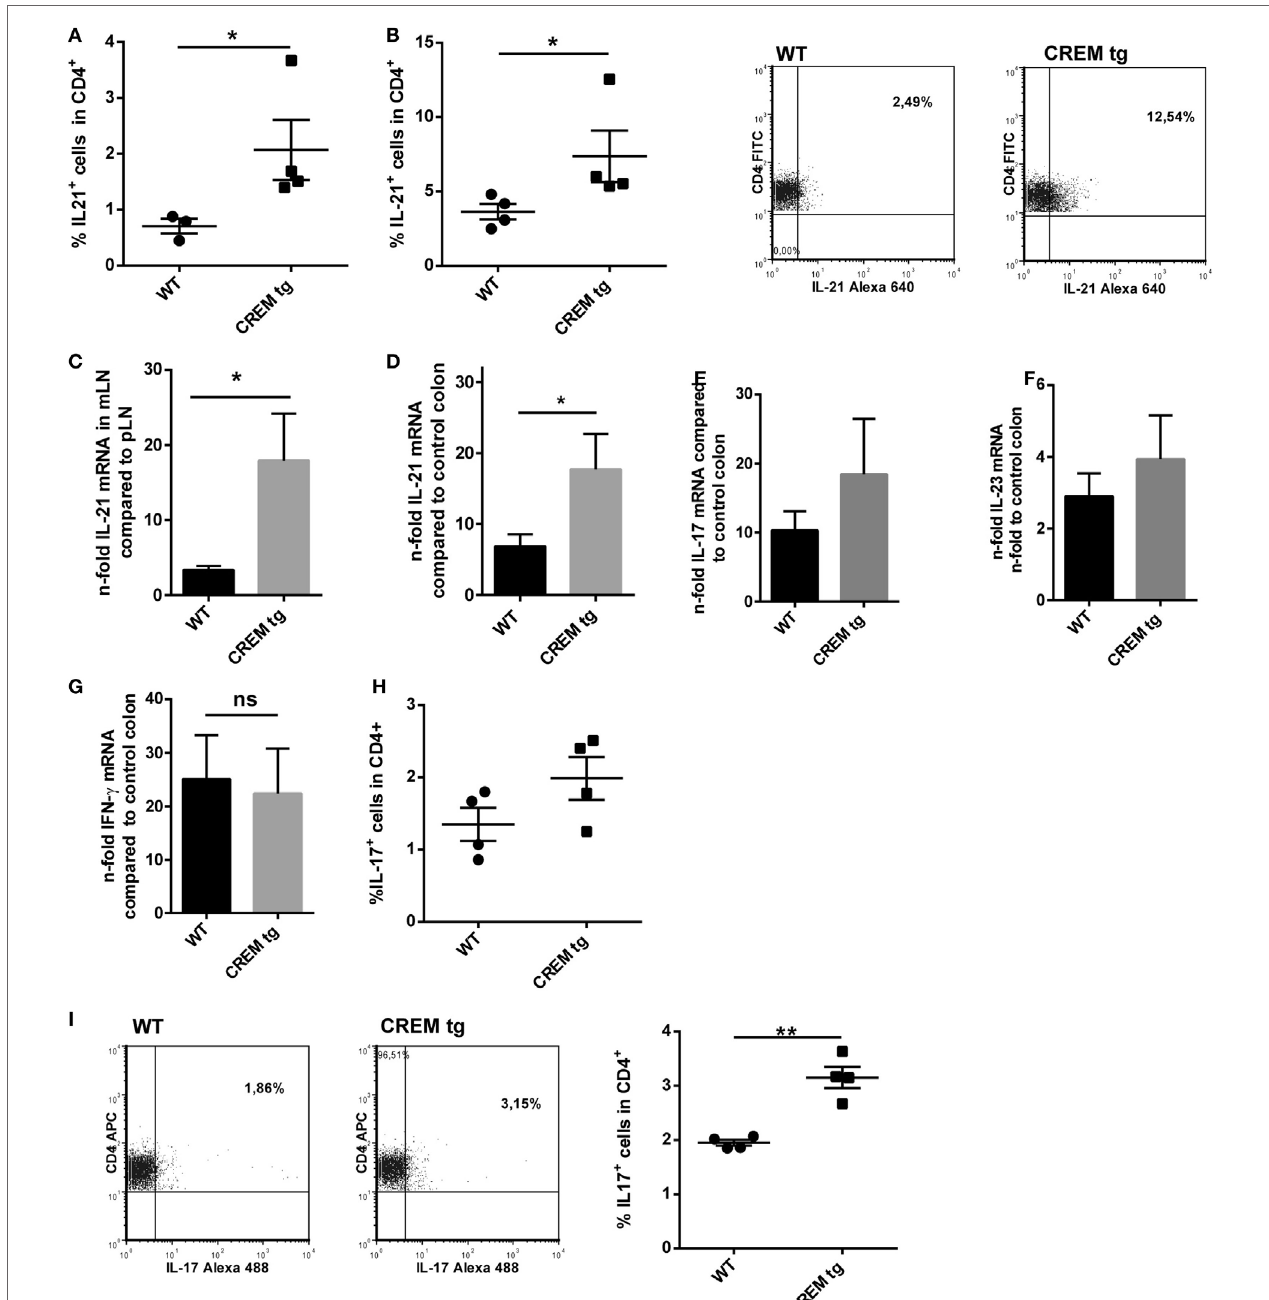
FigUre 5 | colitis in caMP-responsive element modulator alpha (creM α ) transgenic (tg) mice is accompanied by higher local il-21 expression . (a) Percentages of IL-21 expressing CD4 + T-cells in mesenterial lymph node (mLN) and (B) in spleen of age-matched CREM α tg mice and appropriate wild-type (WT) mice after 6 days of colitis induction measured by flow cytometry. Data show mean percentage ± SEM of IL-21 expressing CD4 + T-cells in at least four mice per group (* p < 0.05). Representative flow cytometric dot plots of IL-21-expressing CD4 + T-cells in a CD4 + -gate on the right. (c) mRNA levels of IL-21 in mLN cells ( n -fold compared to IL-21 mRNA in peripheral LN) of CREM α tg mice compared to their WT littermates after 6 days of colitis induction measured by real-time quantitative PCR ( n = 4, * p < 0.05). (D) mRNA levels of IL-21 in colon tissue of CREM α tg mice and appropriate WT mice after 6 days of dextran sodium sulfate (DSS) treatment compared to their untreated WT controls ( n -fold) measured by real-time quantitative PCR ( n = 4, * p < 0.05). (e) mRNA levels of IL-17, (F) IL-23, and (g) IFN- γ in colon tissue of CREM α tg mice and appropriate WT mice after 6 days of DSS treatment compared to their untreated WT controls ( n -fold) measured by real-time quantitative PCR ( n = 4–5). (h) Percentages of IL-17-expressing CD4 + T-cells in mLN and (i) in spleen of age-matched CREM α tg mice and appropriate WT mice after 6 days of colitis induction measured by flow cytometry. Data show mean percentage ± SEM of IL-17-expressing CD4 + T-cells in at least four mice per group (** p < 0.01). Representative flow cytometric dot plots of IL-17-expressing CD4 + T-cells in a CD4 + -gate on the